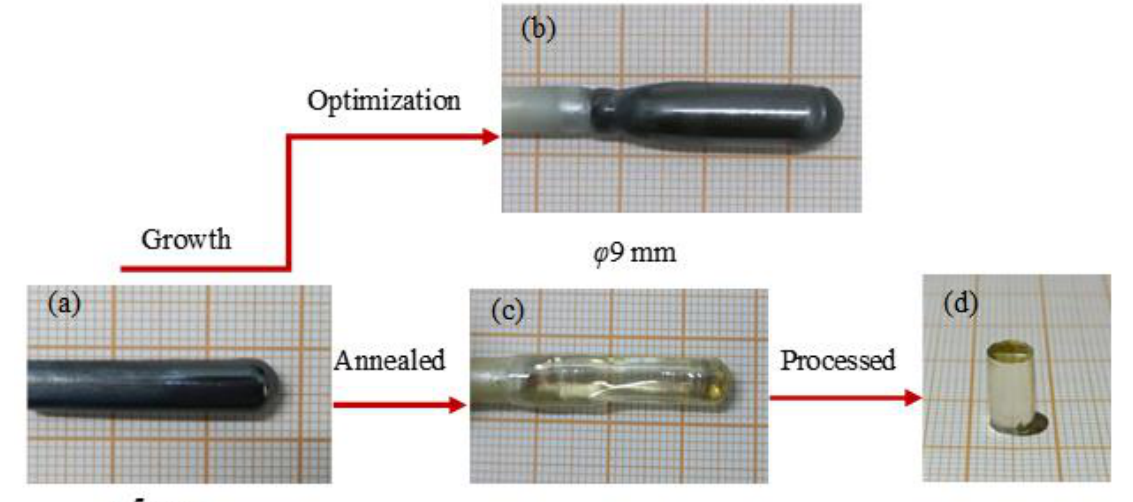
Figure 4. TiO 2 crystals under different processes. ( a ) Before optimization, ( b ) after optimization, ( c ) annealed, and ( d ) processed.